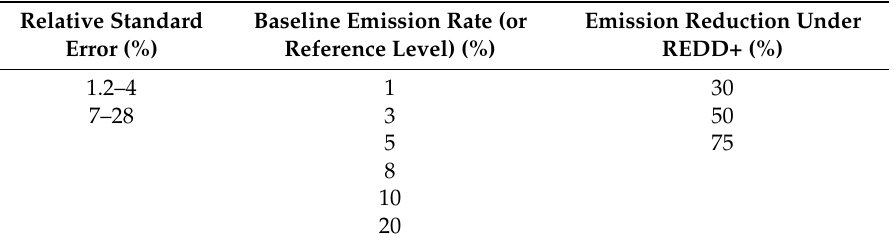
Table 3. The defined set of values for the variables affecting the avoided emissions in the simulation study of Puerto Rico forestry